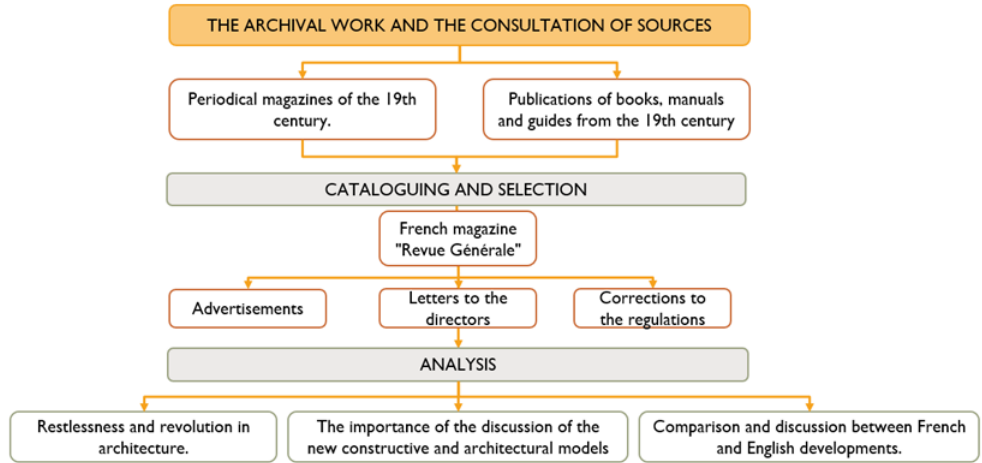
Figure 2. Workflow of the methodology followed in the research.